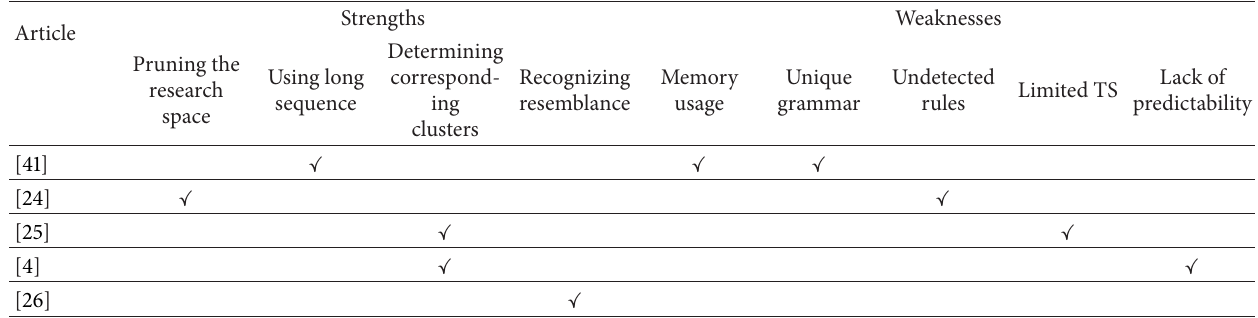
Table 4: Strengths and weaknesses of preproof period researches.